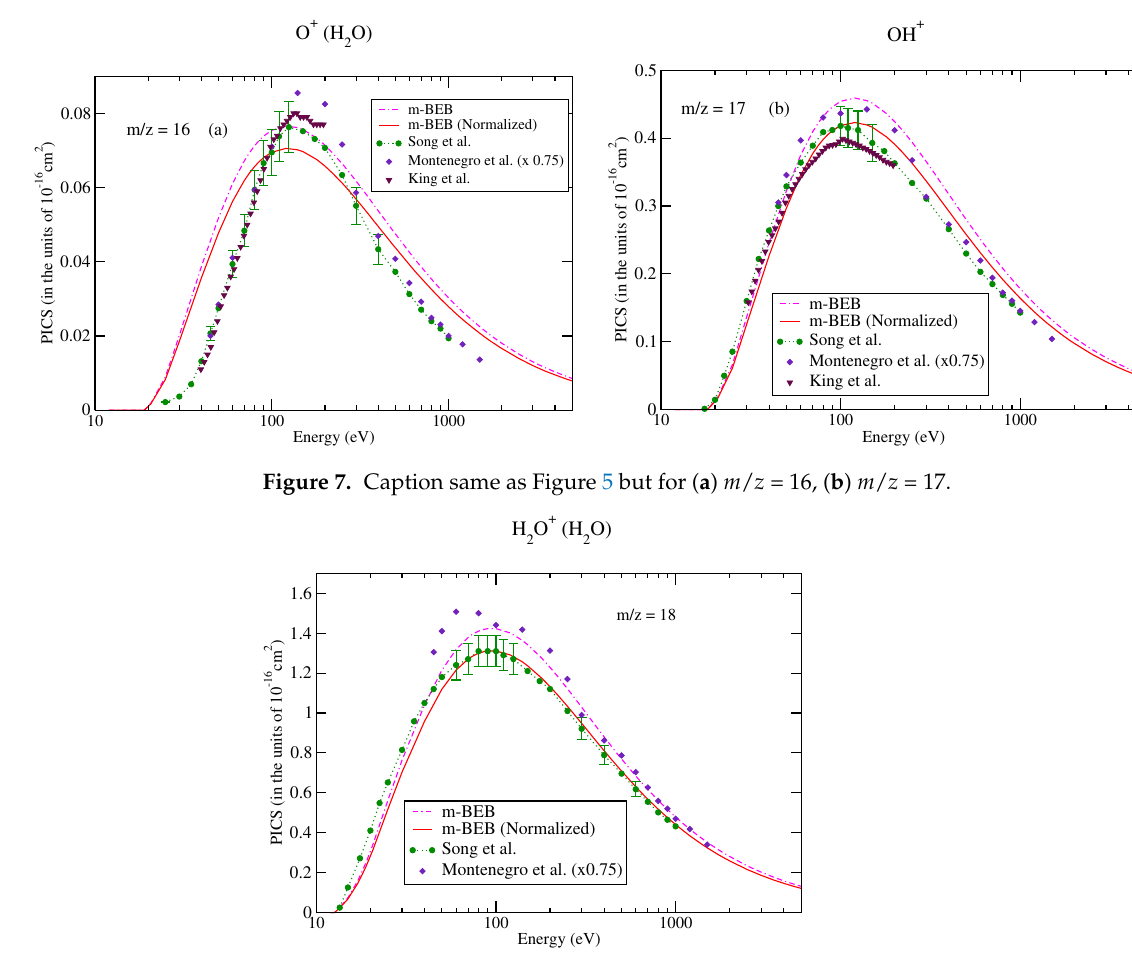
Figure 8. Caption same as Figure 5 but for m / z =